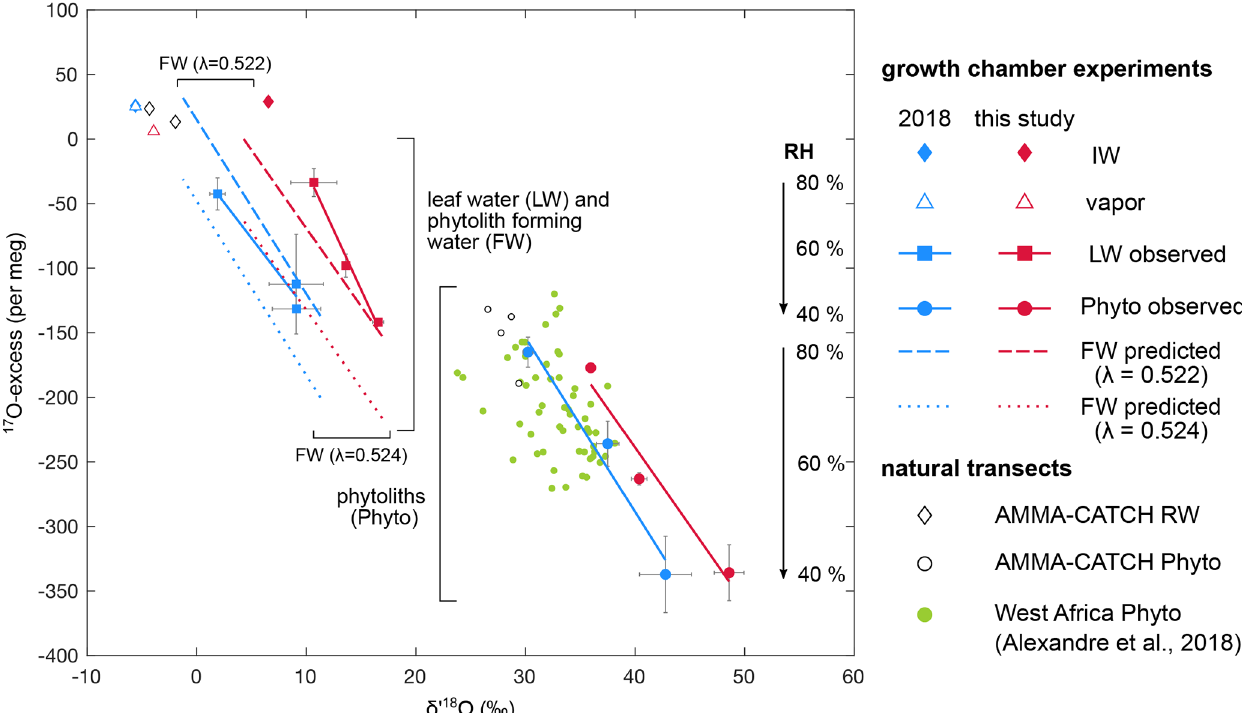
Figure 5. 17 O excess vs. δ (cid:48) 18 O of irrigation water (IW), final water vapor ( V ), bulk leaf water (LW), phytolith (Phyto) and phytolith-forming water (FW) observed and predicted for the current and 2018 RH treatment where RH varies from 40% to 60% and 80%. Phytolith-forming water values are predicted using equilibrium 18 α silica − water estimated from Dodd and Sharp (2010) and λ silica − water values of 0.524 (Sharp et al., 2016) and 0.522 (Table S2). For comparison, values from the 2018 natural transect dataset (Alexandre et al., 2018) and from the AMMA-CATCH grass stem phytoliths and rainwater (RW) data (Table 3) are